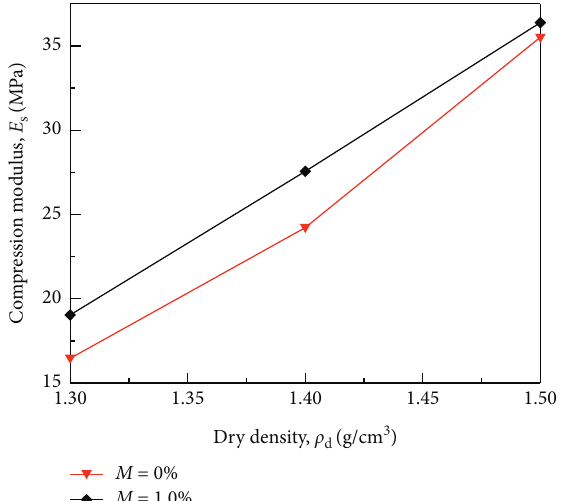
Figure 14: Effect of dry density on compression factor.